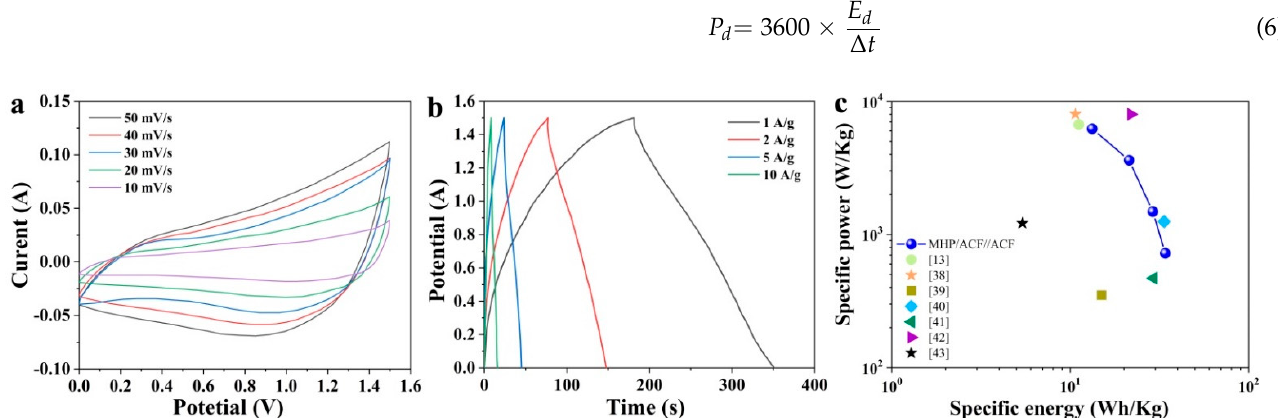
Figure 9. ( a ) CV curves of the MHP nano-sheet arrays/ACF composite//AC hybrid device measured within 0–1.4 V; ( b ) GCD curves of the MHP nano-sheet arrays/ACF composite//AC hybrid device measured t within 0–1.4 V; ( a,c ) Ragone plot of the MHP nano-sheet arrays/ACF composite//AC hybrid devices and other phosphite materials reported in the literature.